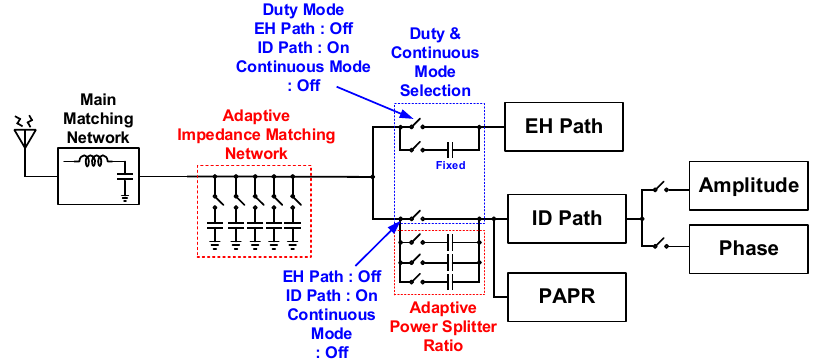
Figure 3. Adaptive impedance matching network and power-splitter blocks being controlled by field-programmable gate array (FPGA). 186